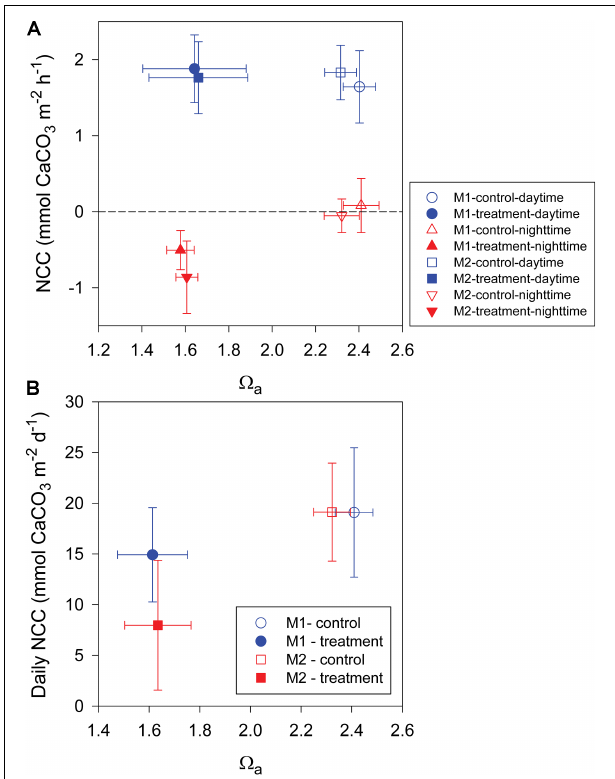
FIGURE 5 | (A) Average daytime and nighttime net community calcification (NCC) and (B) average daily NCC versus seawater aragonite saturation state ( (cid:127) a ) in mesocosms I (M1) and II (M2) during the control and treatment